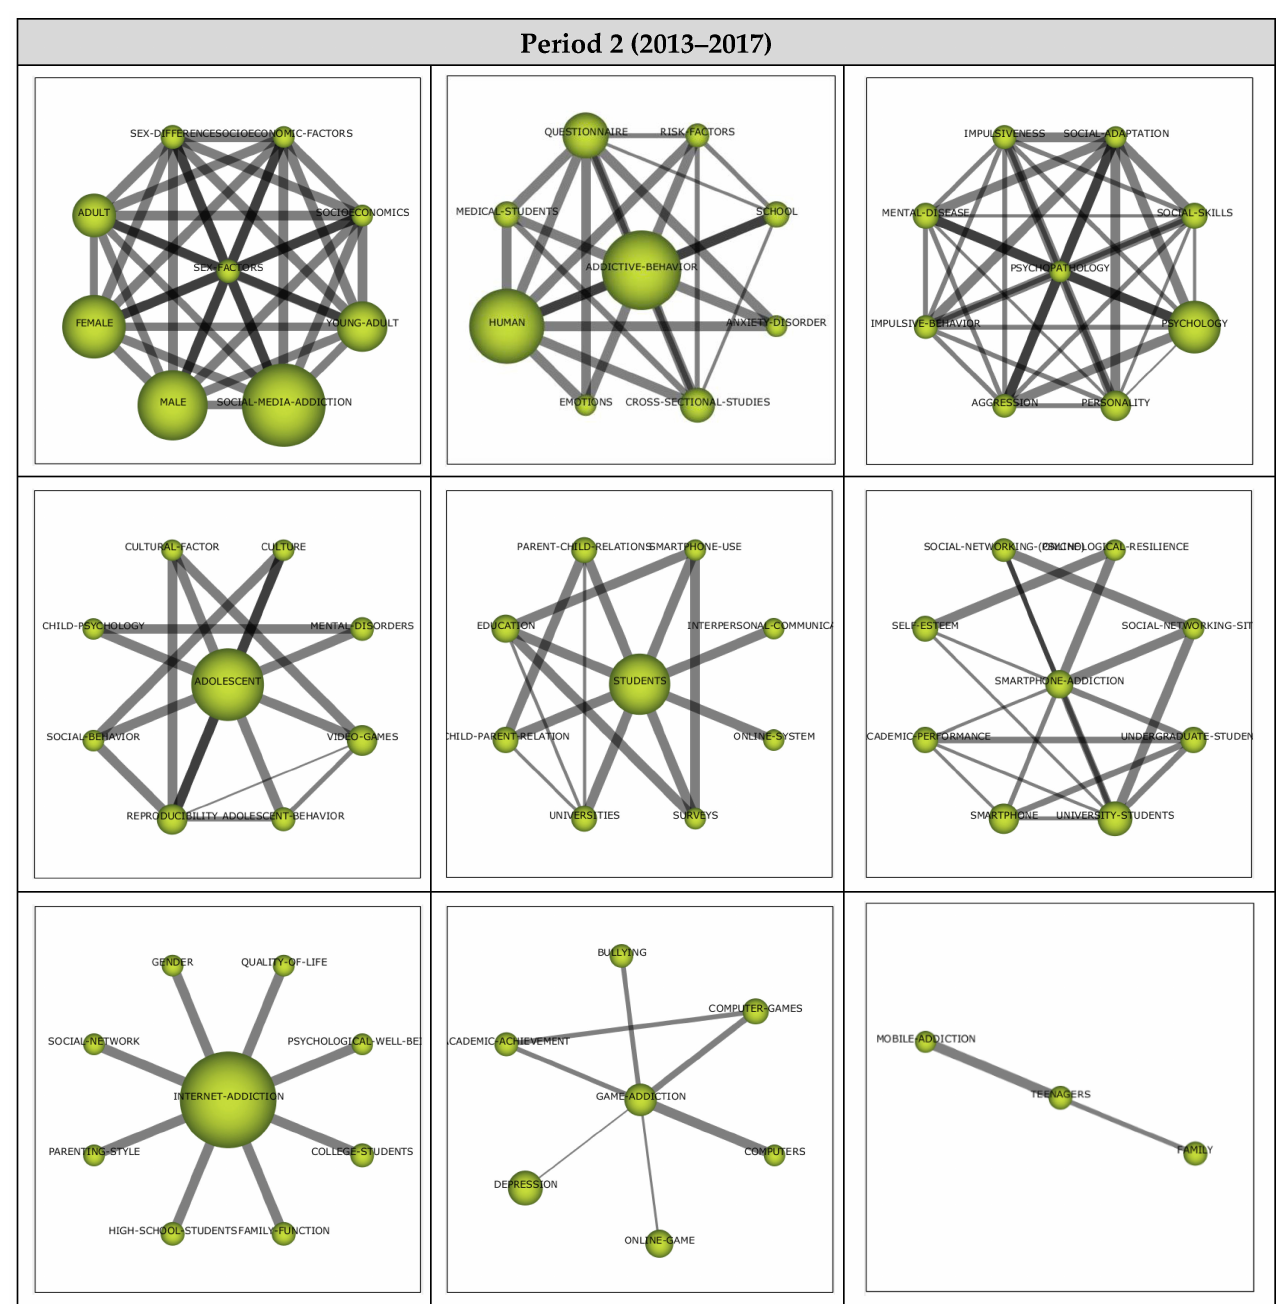
Figure 7. Period 2: Thematic network